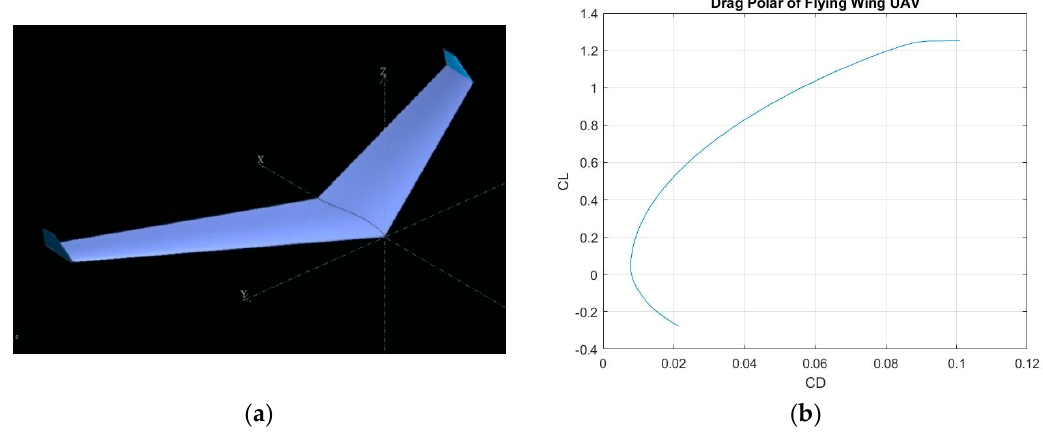
Figure 4. ( a ) 3D wing planform of flying wing UAV and ( b ) drag polar.